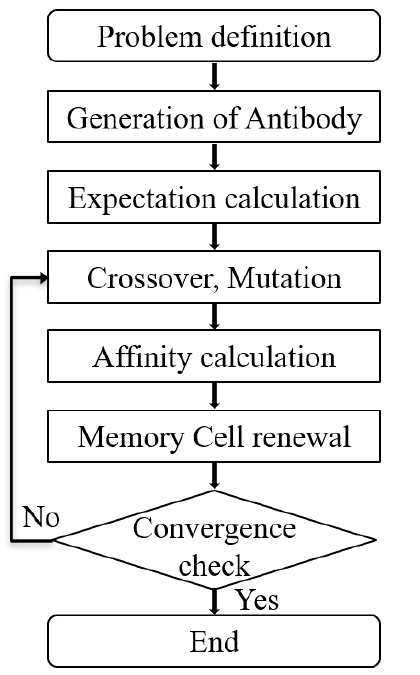
Figure 1. Flow chart of the conventional immune algorithm.